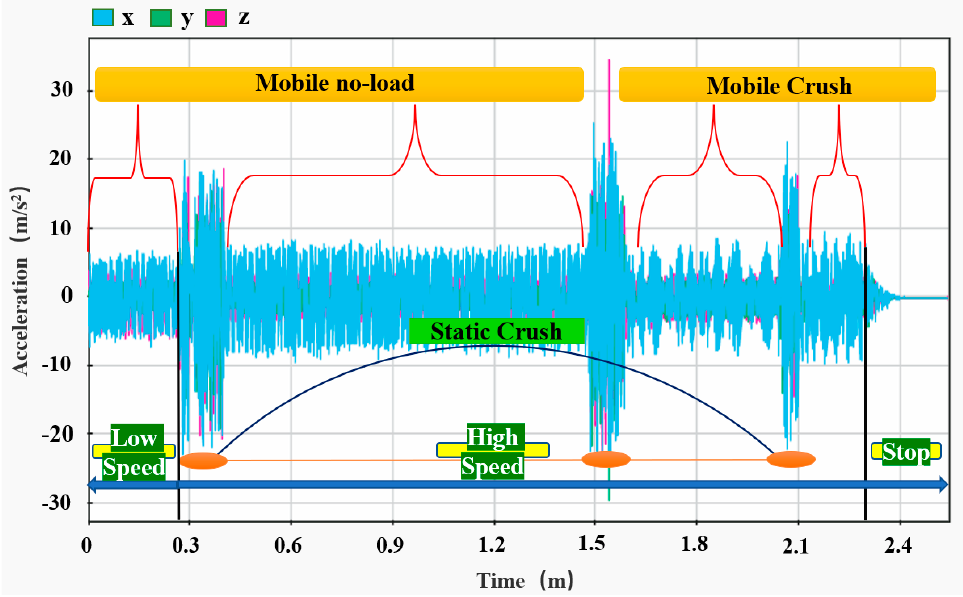
Figure 17. Operation time frequency diagram of the tractor protection frame of the chipper: ( a ) three-way time–frequency diagram; ( b ) time–frequency diagram in the x-direction; ( c ) time– frequency diagram in the y-direction; ( d ) time–frequency diagram in the z-direction.